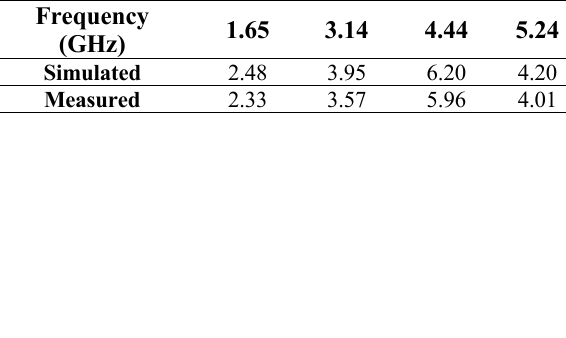
Table 2: Simulated and measured realized gain